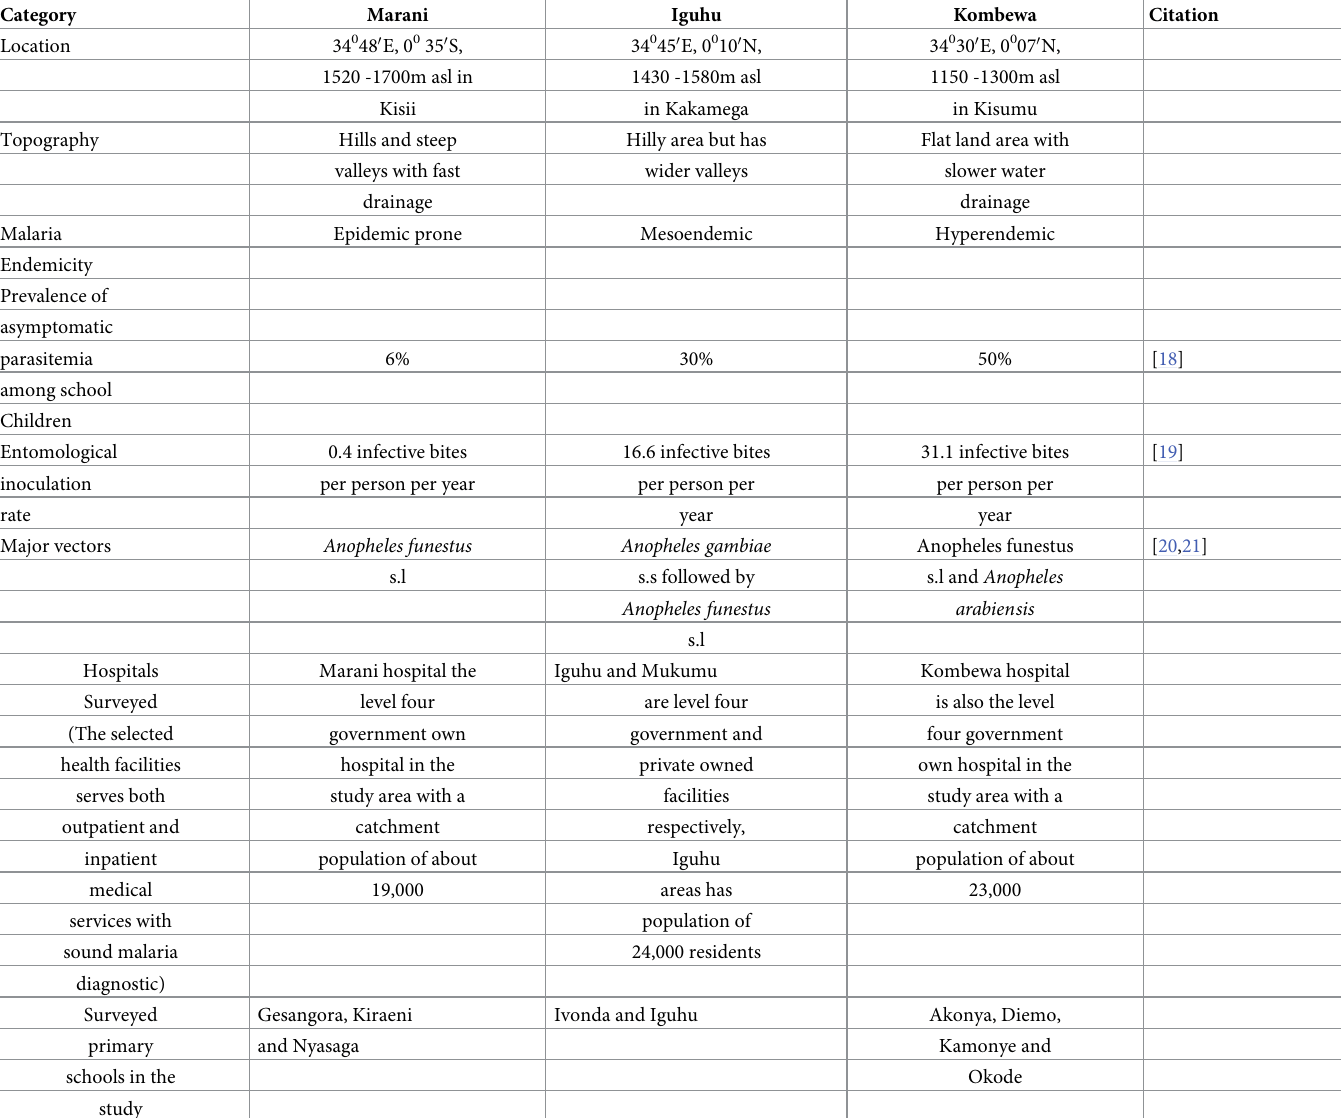
Table 1. Description of the study areas with different malaria transmission intensities in western